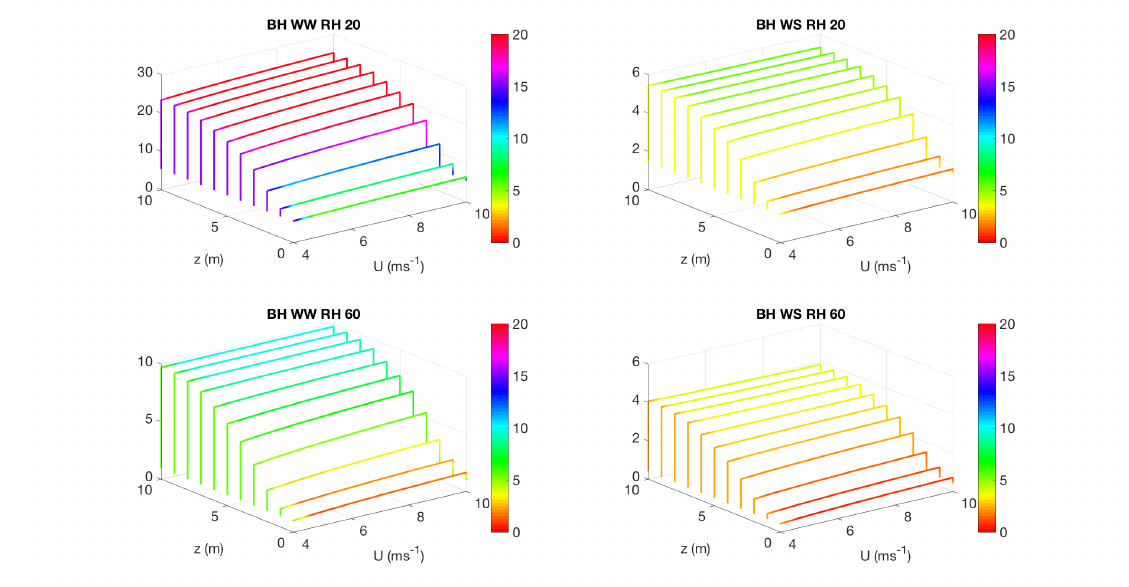
Figure 8. Variations of leaf level transpiration fe (molm − 2 leafs − 1 ) with wind speed U and height z for the bottom heavy (BH) scenario for the following four cases in high light conditions. WW RH20 means well watered, high evaporative demand; WS RH20 means water stressed, high evaporative demand; WW RH60 means well watered, low evaporative demand; WS RH60 means water stressed, low evaporative demand. Color bars show fe multiplied by 1000, x axes show wind speed U in ms − 1 and y axes show canopy height z in